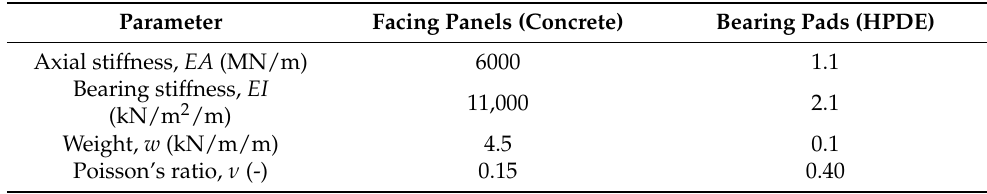
Table 2. Precast concrete panel and bearing pad (joint) properties. Parameter Facing Panels